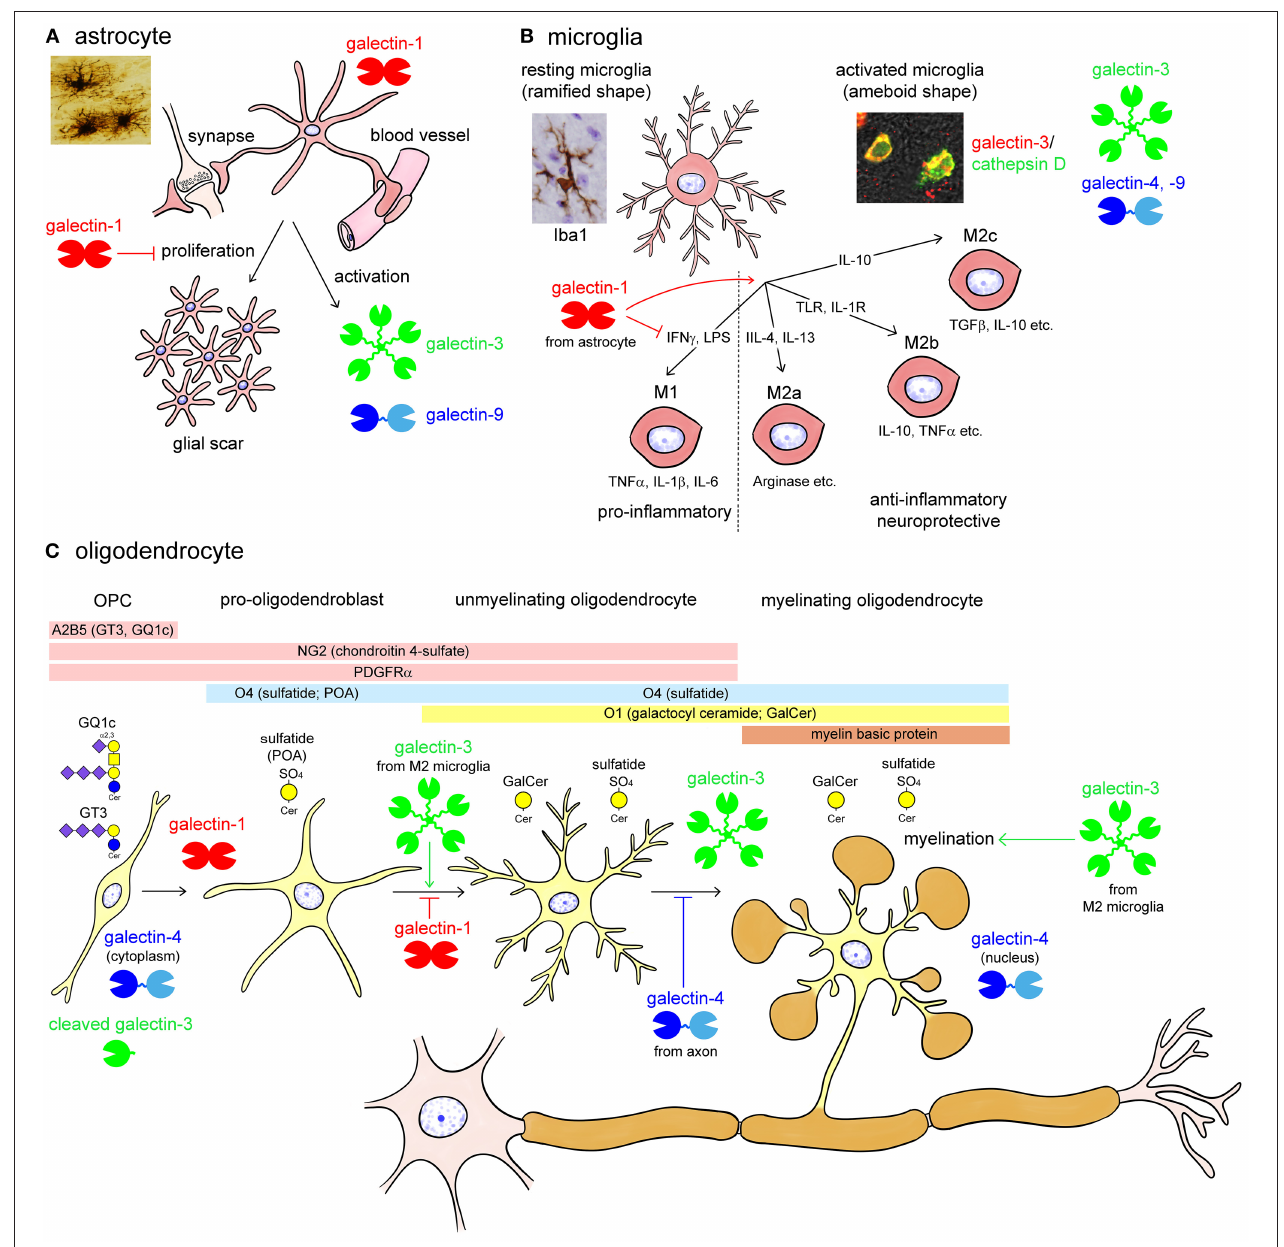
FIGURE 3 | Summary images of galectin expression in glial cells ( A ; astrocytes, B ; microglia, and C ; oligodendrocytes) in the central nervous system (CNS). Astrocytes are supporting cells and surround the synapse and the blood vessels forming the blood-brain barrier in the CNS (A) . Astrocytes predominantly contain galectin-1 and activated astrocytes express galectin-3 and -9 (A) . Astrocytes proliferate in response to brain injury, forming a glial scar. Galectin-1 inhibits the proliferation and promotes differentiation of astrocytes, protecting neural function (A) . Microglia is responsible for controlling neural inflammation (B) . Resting microglia with elongated fine processes, so-called ramified-shaped microglia, activated by various stimuli including interferon γ (IFN γ ), lipopolysaccharides (LPS), interleukin (IL)-4, IL-13, toll-like receptor (TLR) and IL-1 receptor stimulation, and IL-10 into pro-inflammatory M1 phenotype and anti-inflammatory, neuroprotective M2 (M2a, M2b, and M2c) phenotypes with ameboid shape (B) . Activated microglia abundantly contain galectin-3, and also express galectin-4 and -9. On the contrary, galectin-1 de-activates M1 type microglia, facilitating the shift from M1 to M2 phenotype (B) . Oligodendrocytes are myelinating cells in the CNS and are differentiated from oligodendrocyte precursor cells (OPC) reactive for monoclonal antibody (mAb) A2B5, which recognizes c-series gangliosides such as GT3 and GQ1c (C) . OPCs are also immunoreactive for chondroitin 4-sulfate-recognizing NG2 antibody and express platelet-derived growth factor receptor α (PDGFR α ) (C) . Pro-oligodendroblasts contain sulfatide recognized by mAb O4 in addition to the OPC markers, NG2 and PDGFR α , and differentiated into oligodendrocytes, which contain galactosyl ceramide (GalCer) reactive for mAb O1. O4 recognizes sulfatide with short-chain fatty acids in pro-oligodendroblasts, called pro-oligodendroblast antigen (POA). Myelinating oligodendrocytes contain myelin basic protein forming myelin membrane around the axon. Galectin-1 is expressed in O1-negative OPC and pro-oligodendroblasts whereas galectin-3 is abundant in differentiated oligodendrocytes (C) . Galectin-4 localizes to the cytoplasm of OPC whereas in the